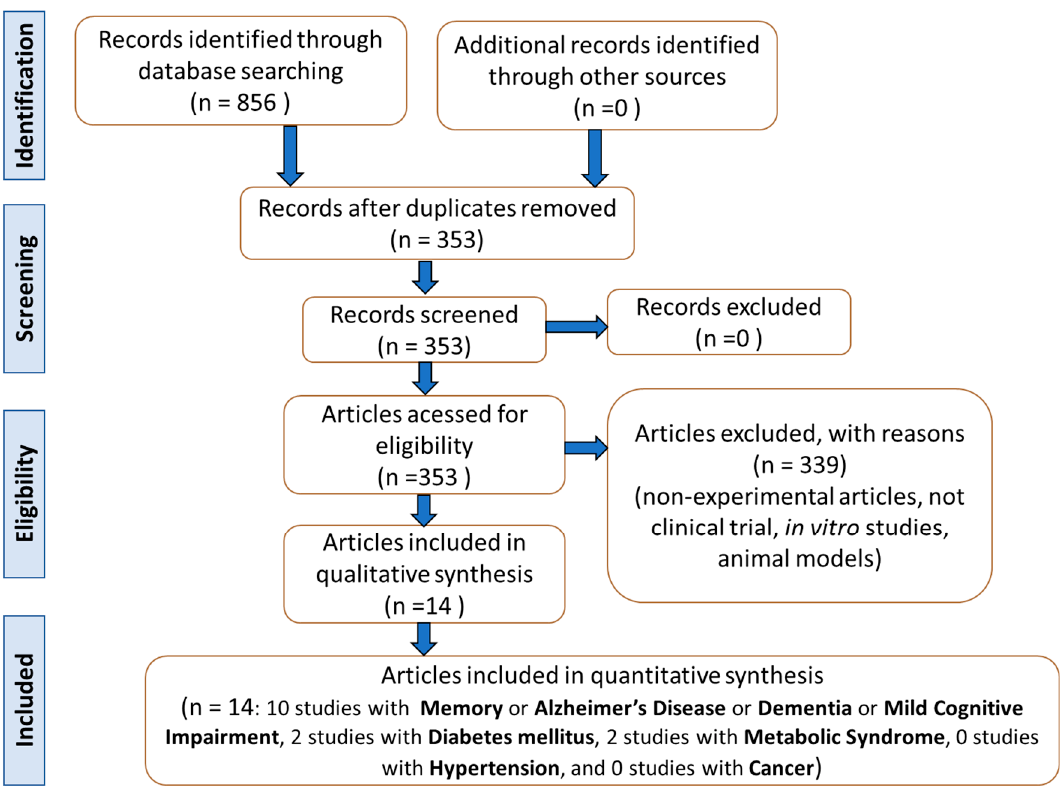
Figure 2. Flow diagram showing the study’s selection criteria (based on PRISMA guidelines).